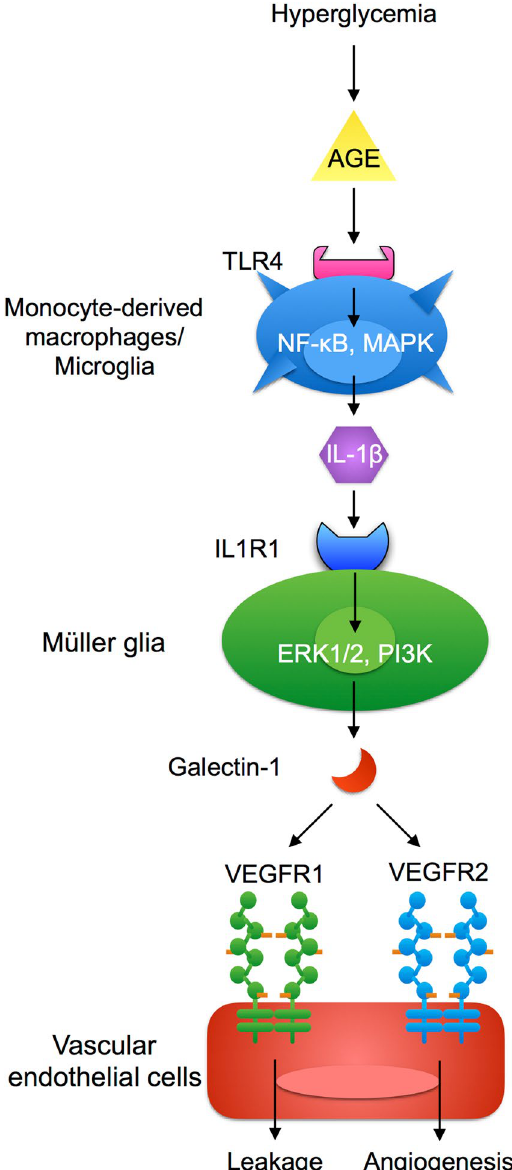
Figure 8. A schema showing the involvement of AGE-triggered inflammatory cues linking to galectin-1 upregulation in the pathogenesis of DR. AGE accumulation due to prolonged hyperglycemia triggers cellular (macrophage) and molecular (IL-1 β ) inflammatory cues linking to glial galectin-1 production, explaining the DR-selective elevation of galectin-1 along with disease activity (Fig. 1A). Galectin-1 binds to VEGFR1 and VEGFR2 in endothelial cells, leading to vascular leakage 16 and angiogenesis 14,15 ,